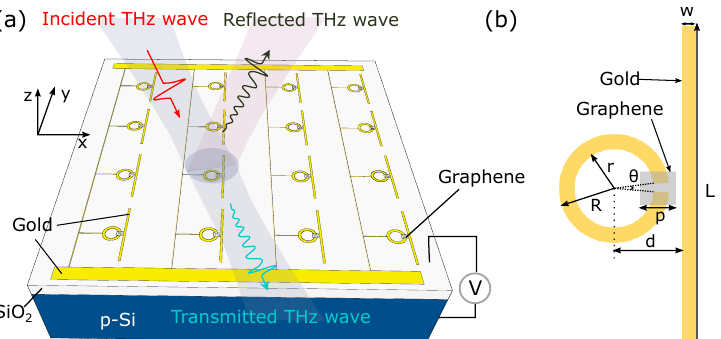
Figure 1. ( a ) The schematic diagram of overall device architecture with electrostatic back gating. The backside of the device coated with gold bond pads is connected to the ground. The DC conductivity of graphene is a function of the back-gated voltage, V. ( b ) Representative design of a unit cell. The geometrical parameters are L = 29 µ m, W = 1.5 µ m, R = 5.5 µ m, r = 4 µ m, p = 3 µ m, d = 7 µ m, and θ = 10 ◦ , respectively.